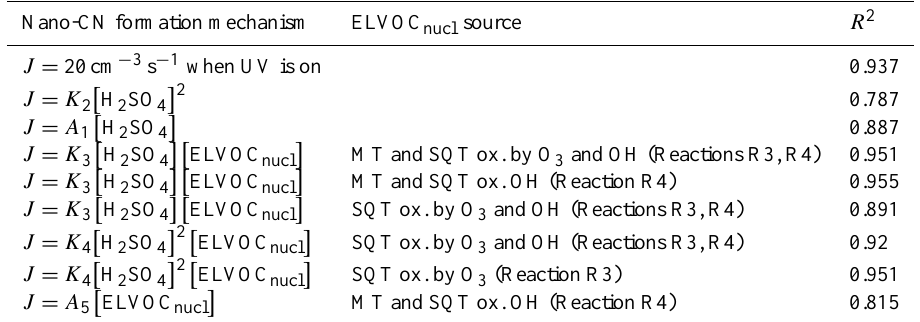
Figure 10. Modelled and measured particle number size distribution from (a) Day 1, (b) Day 2, (c) Day 3 and (d) Day 4 of the experimental , 1, 2 and 5h after the UV light was turned on. The model results are from a campaign. The particle number size distributions are from 1 2 simulation with the 2-D VBS (including ELVOC formation (Reactions R1 and R2)) and the full-moving size distribution method. Table 3. Coefficient of determination ( R 2 ) between the modelled and measured (PSM-CPC) total particle number concentration during the experimental